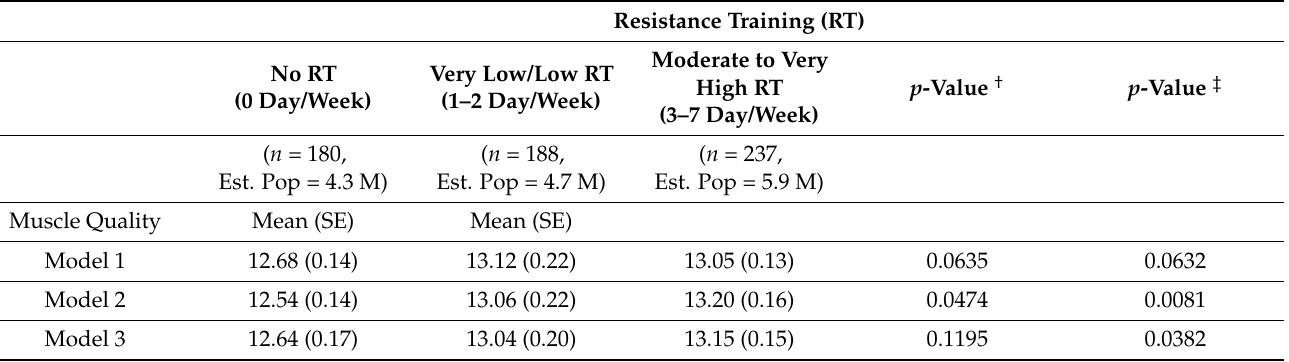
Table 3. Association between resistance training (0 day/week, 1–2 day/week, and 3–7 day/week) and muscle quality (age 12–15 years old).